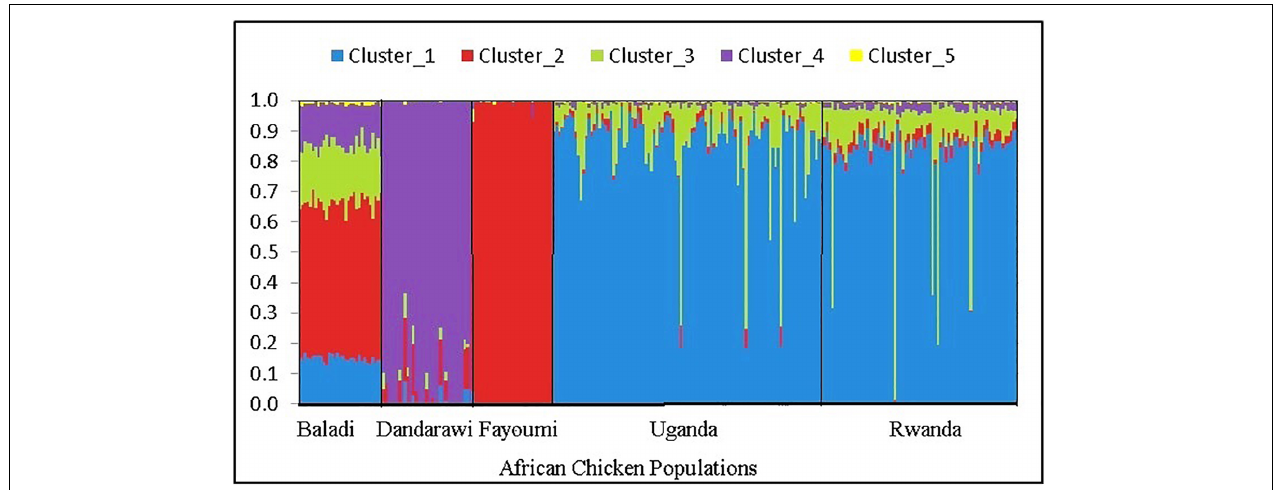
FIGURE 2 | Admixture analysis plot for the five native African chicken populations, based on ancestral model-clustering, with no prior knowledge on breed origins. The optimum number of clusters (ancestral genetic background) k = 5. The five African chicken populations from left to right are three North-African (Baladi; N = 31; Dandarawi, N = 33; and Fayoumi, N = 30) and two East-African (Rwanda, N = 100 and Uganda, N = 72) populations.